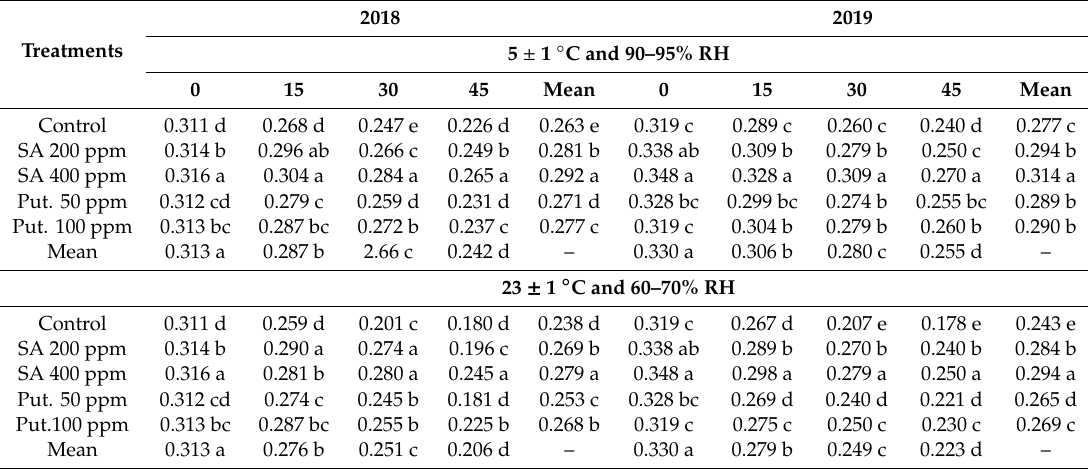
Table 2. E ff ect of salicylic acid (SA) and putrescine (Put) on firmness (N) of Murcott mandarin fruit at harvest and 15, 30, and 45 days of storage during 2018 and 2019